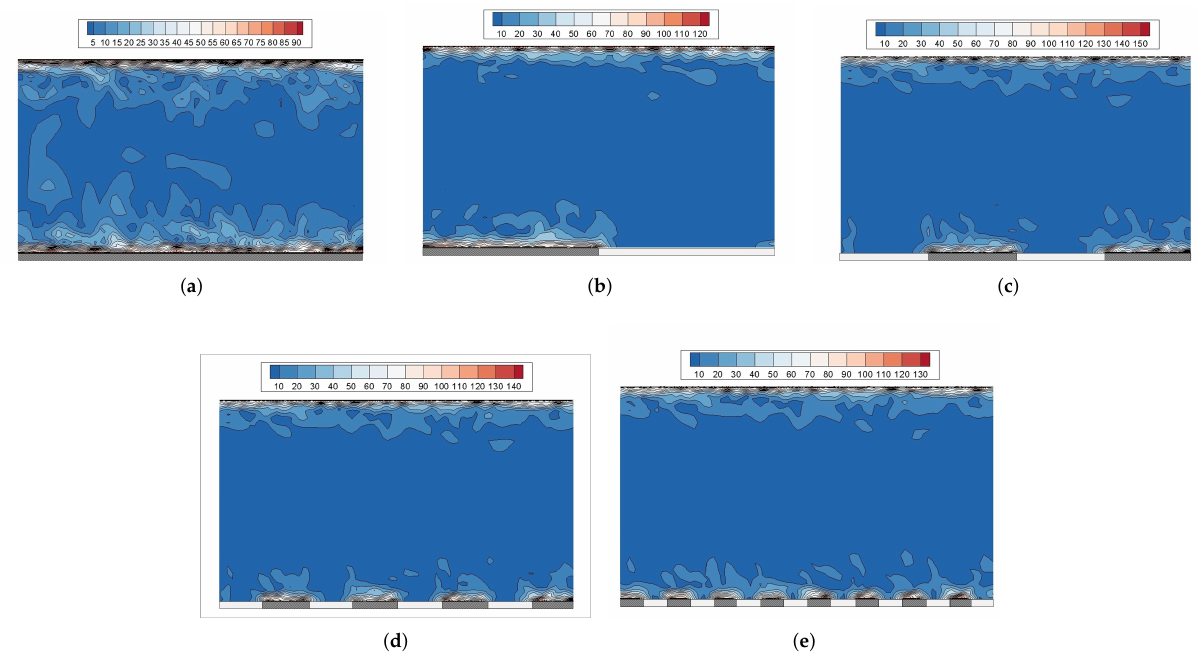
Figure 10. YZ = 3.5 δ cutplane contours of vorticity at different strip numbers.